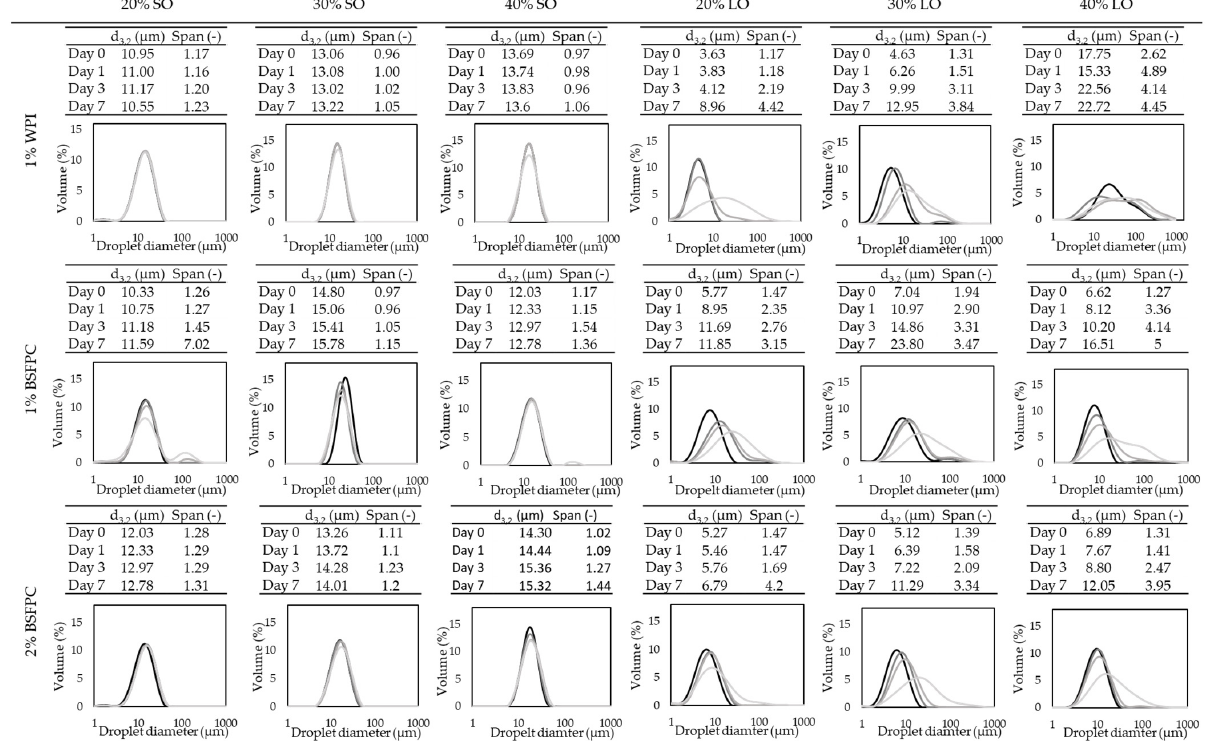
Figure 9. Particle size distribution of SO (sunflower oil) and LO (lemon oil) emulsions (no buffer added) stabilized by 1%WPI (whey protein isolate), 1% BSFPC (black soldier fly protein concentrate), and 2% BSFPC at day 0, day 1, day 3, and day 7 of storage at room temperature (25 °C). The color transparency scale indicates the length of storage time: from darkest to lightest refer fresh emulsion (day 0), day 1, day 3, and day 7.